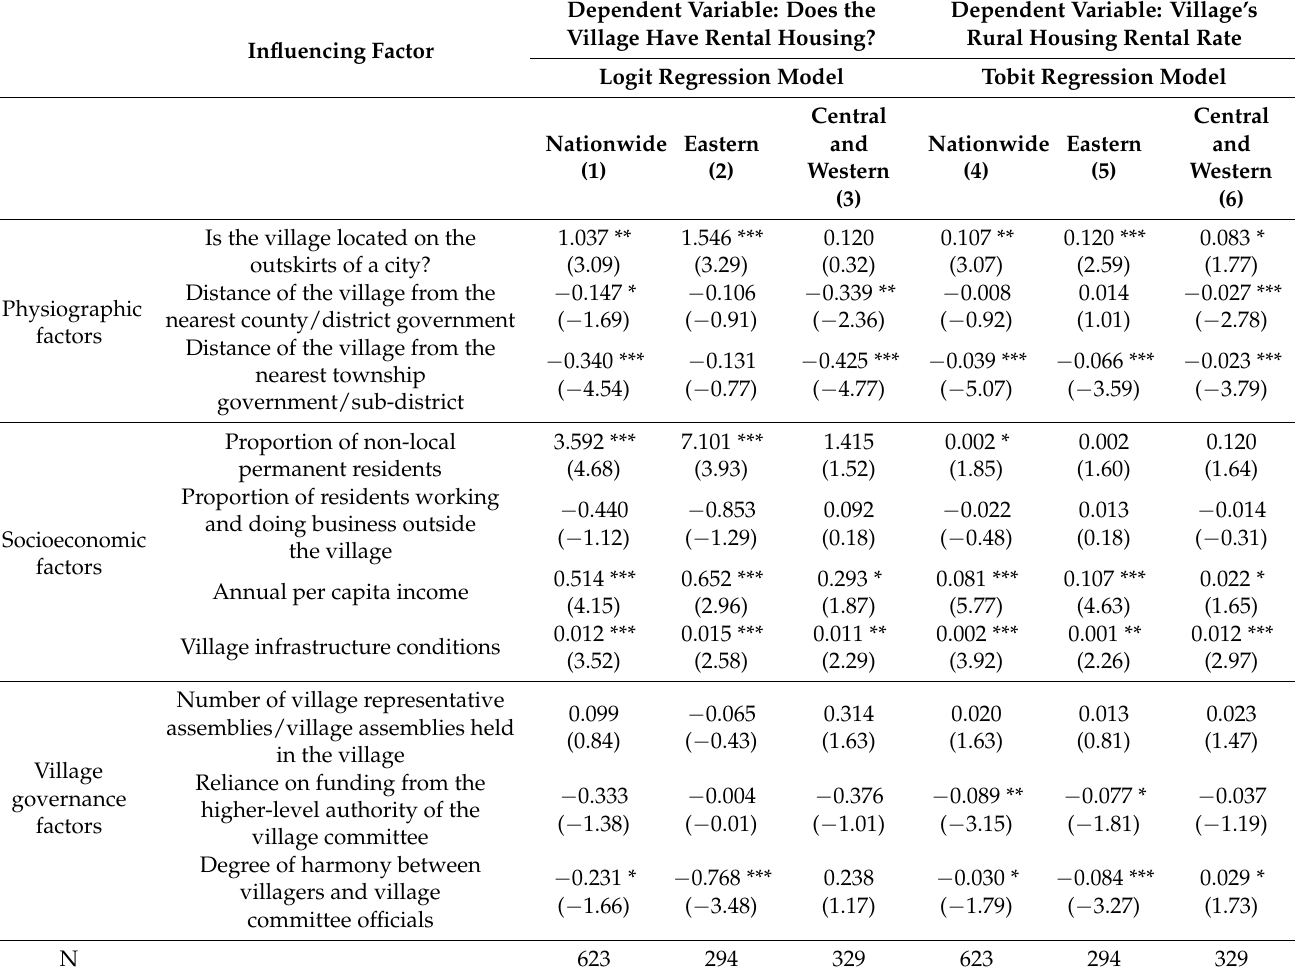
Table 4. Regression results of factors influencing the rural housing rental rate in